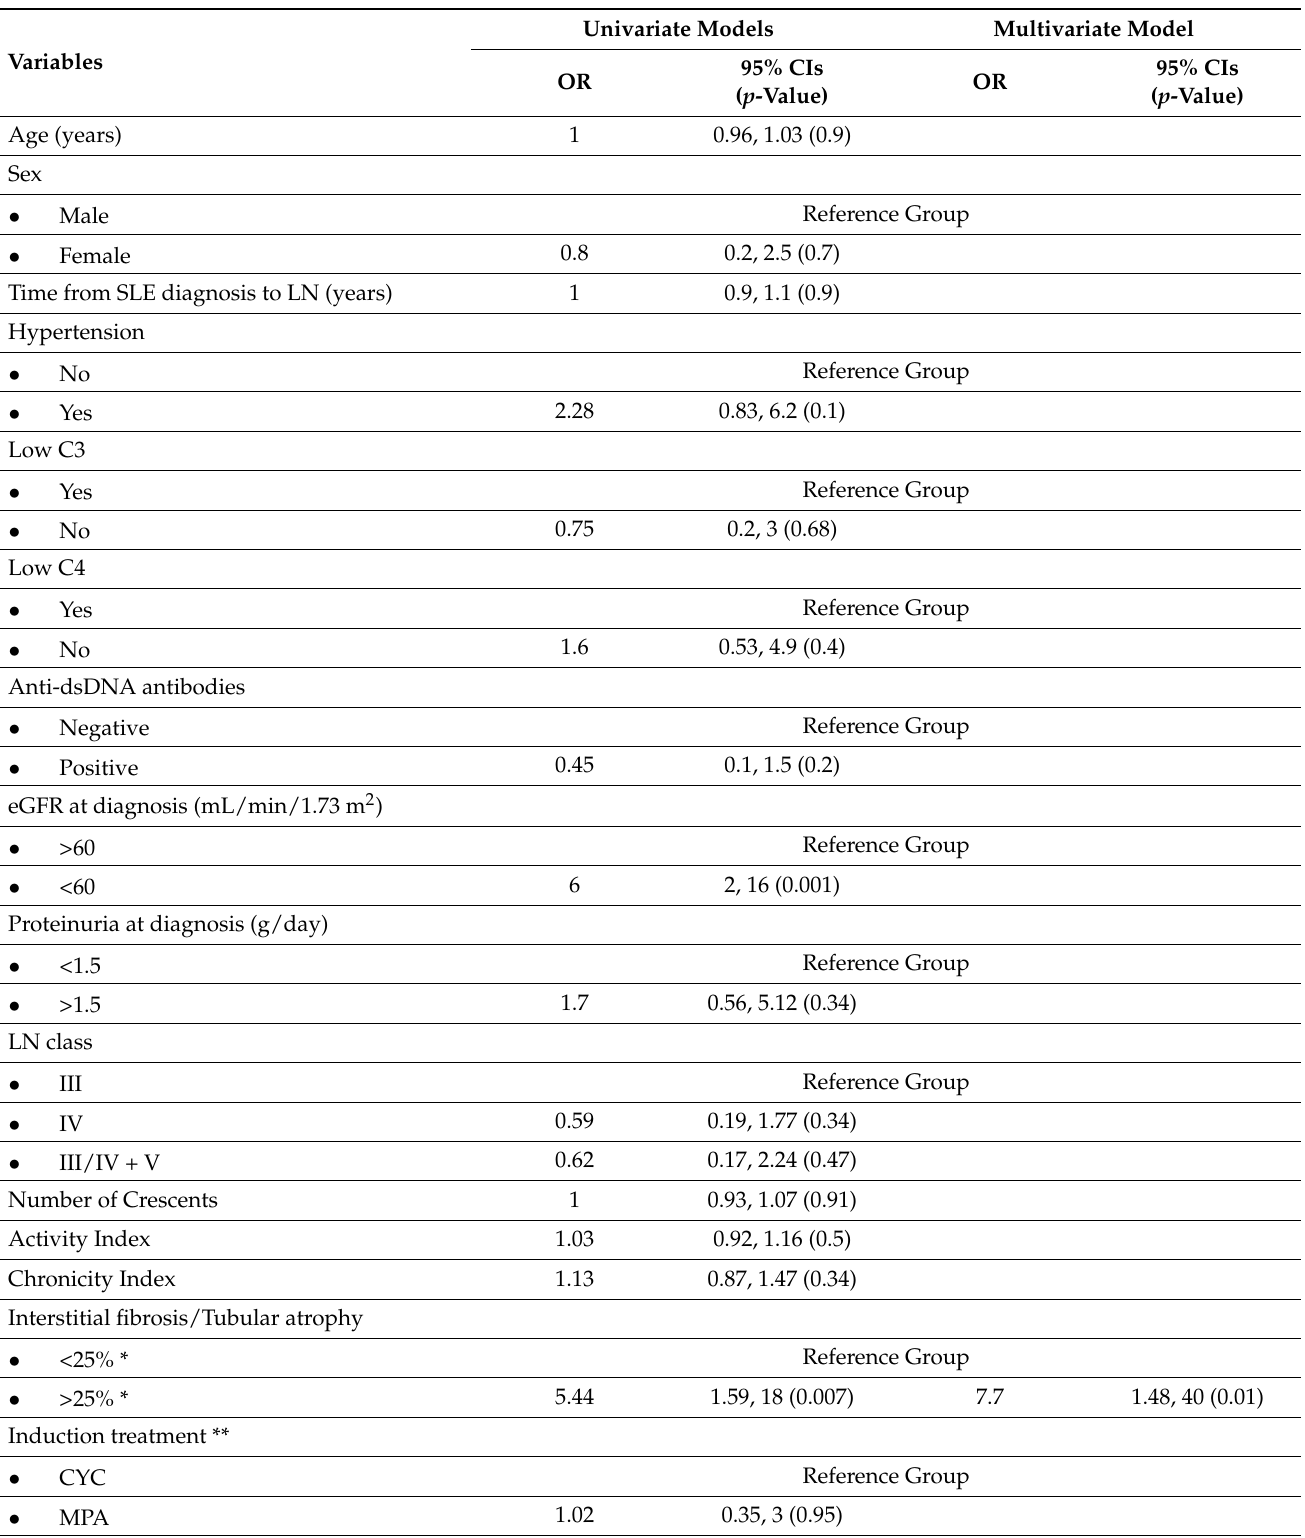
Table 4. Predictors of long-term adverse renal outcome (stage 3–4 CKD,